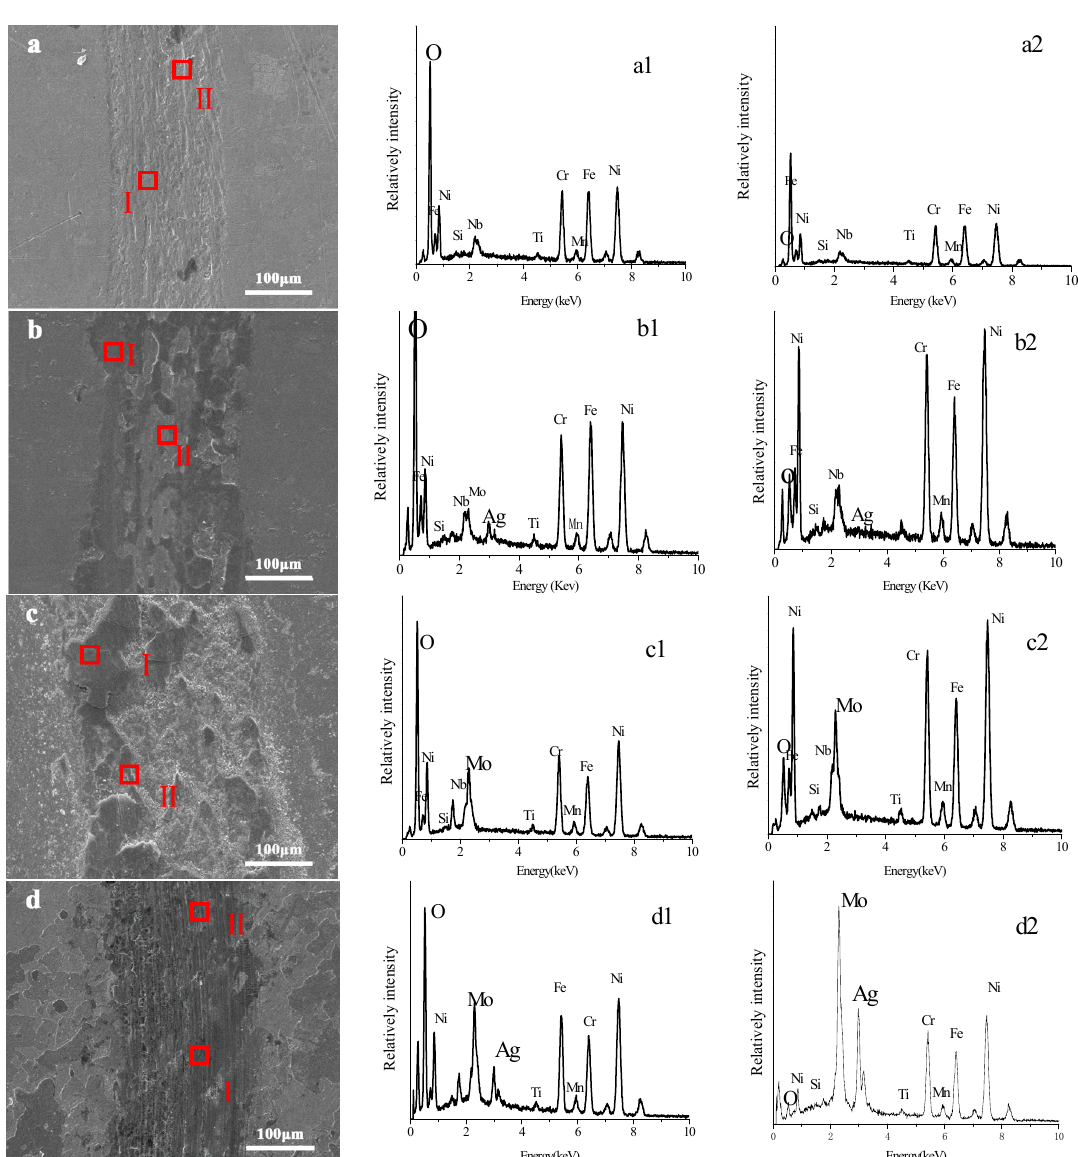
Figure 7. The SEM micrographs of the worn surfaces after the fiction test for ( a ) N, ( b ) A, ( c ) M, and ( d ) AM.